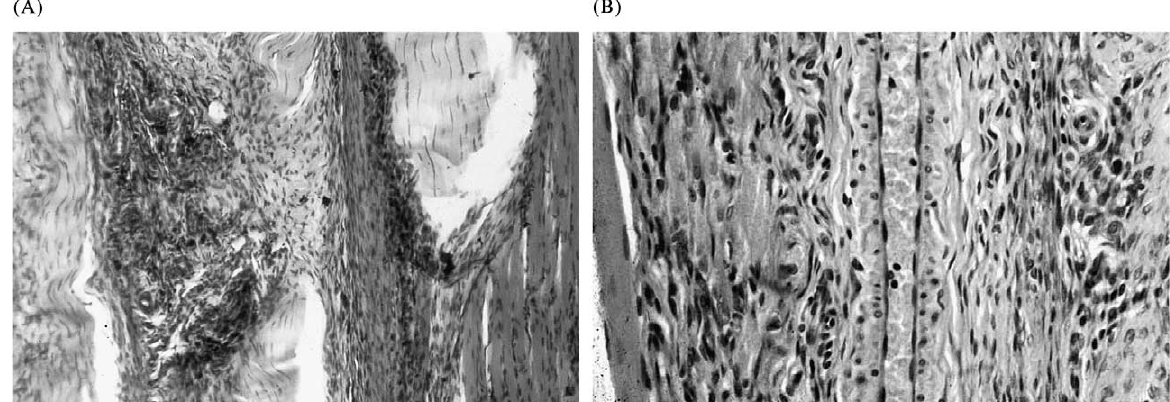
FIG. 5. Four weeks after tendon injury in the L-NAME-treated rat: (A) (cid:4) / 10 and (B) (cid:4) / 40, haematoxylin and eosin. Increased numbers of inflammatory cells in the subcutaneous tissues, in muscle and in tendon. Mononuclear cells are much larger (B) than at 2 or 3 weeks. There are few areas of clear synovial canal, and the tendon has completely merged with the interstitial tissues in some areas. Mediators of Inflammation (cid:1) Vol 13 (cid:1)